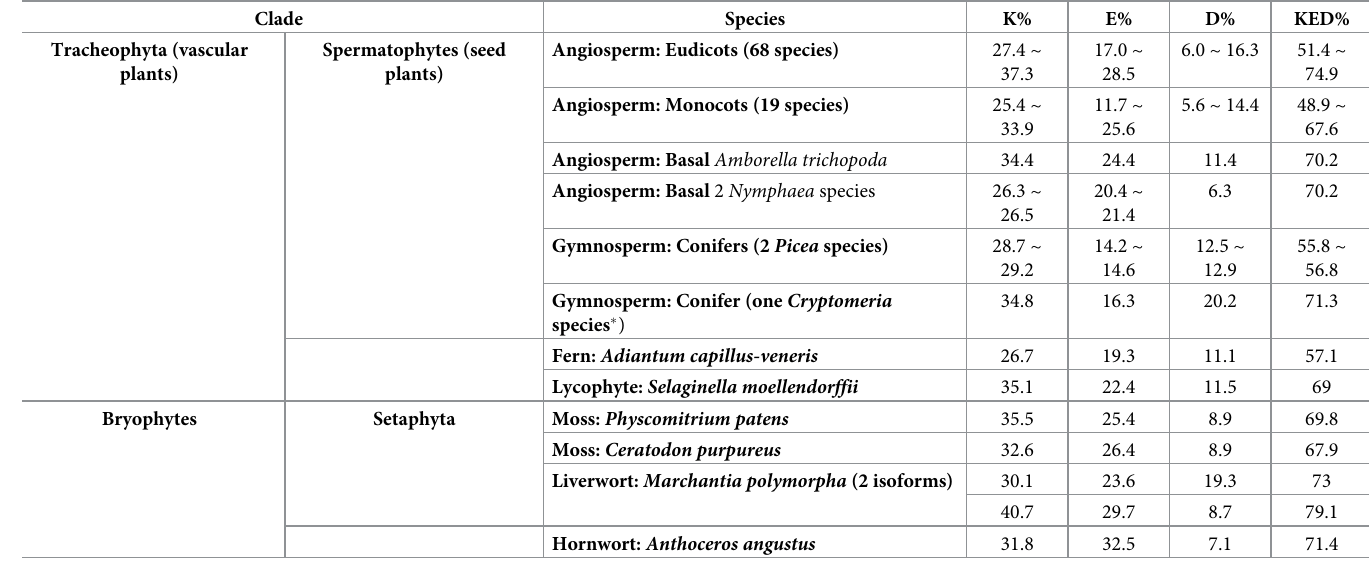
Table 1. Summary of calculated parameters of land plant (Embryophyte) KED-rich proteins.